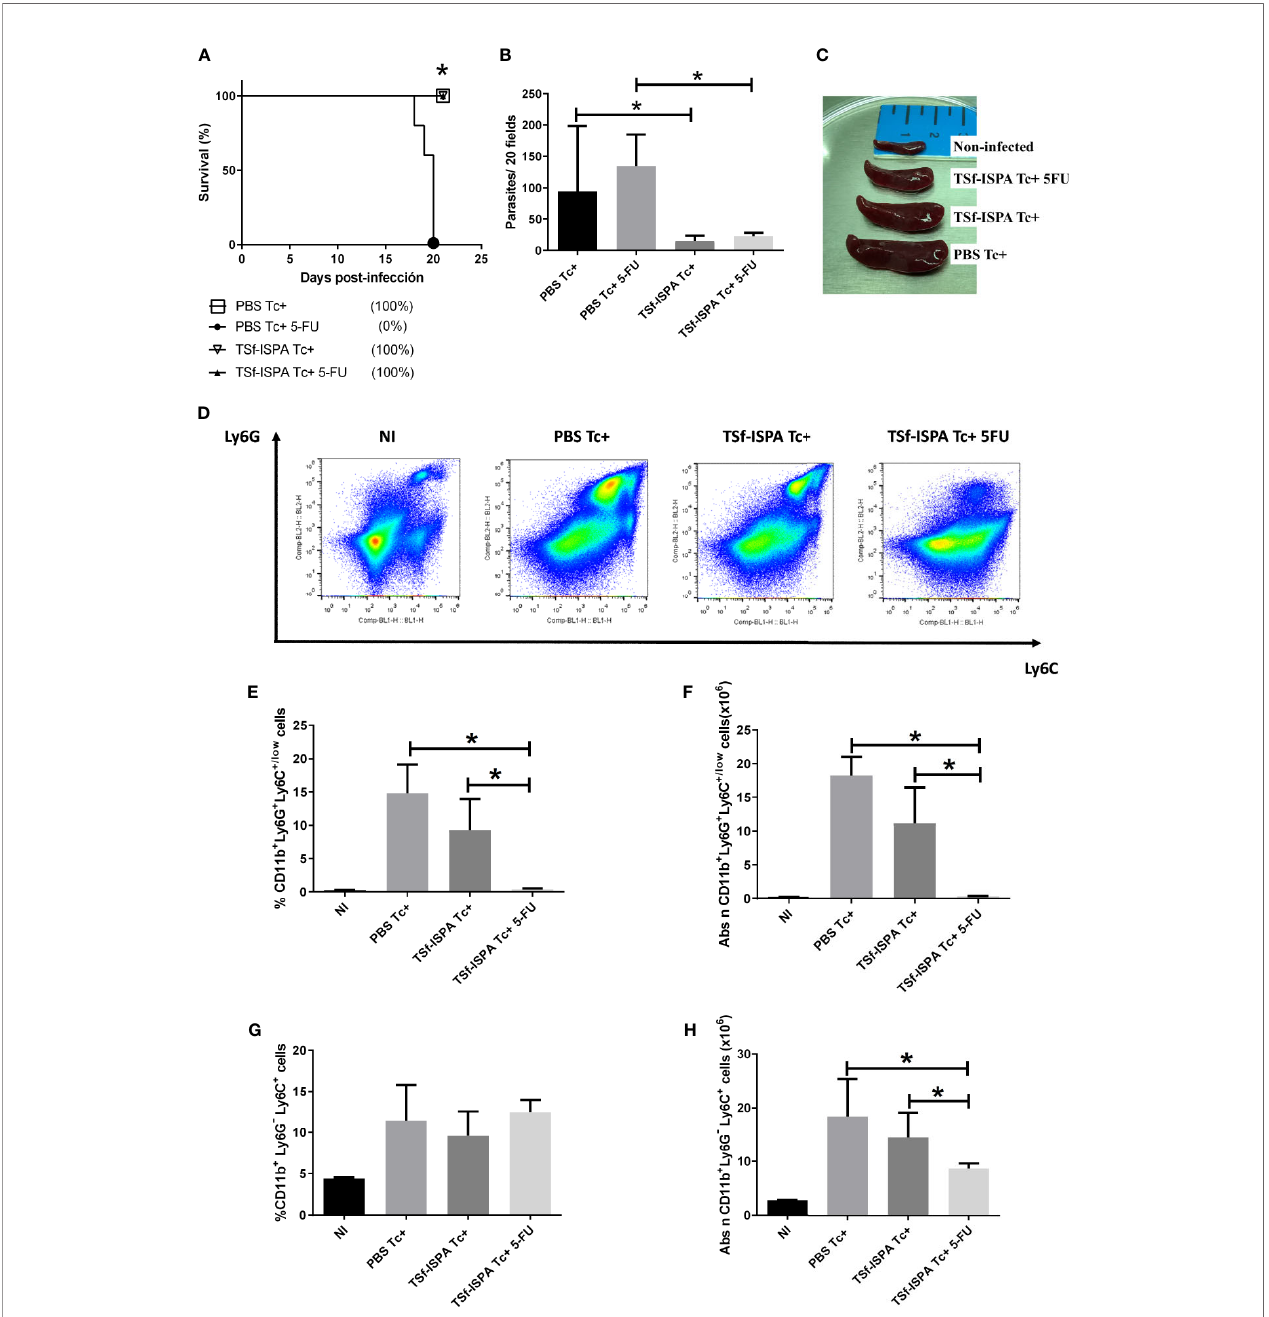
FIGURE 1 | 5FU treatment at day 15 p.i. strongly affects MDSCs and clinical parameters of T. cruzi infection. Mice immunized with TSf-ISPA or PBS were treated or not with 5FU and challenged with 900 trypomastigotes of the Tulahuen strain. (A) Survival rates are shown for TSf-ISPA immunized and infected mice (TSf-ISPA Tc+), PBS-inoculated and infected mice (PBS Tc+), TSf-ISPA immunized, infected and 5FU-treated mice (TSf-ISPA Tc+ 5FU) and PBS-inoculated, infected and 5FU-treated mice (PBS Tc+ 5FU). (B) Parasitemia from PBS Tc+ mice, PBS Tc+ 5FU mice, TSf-ISPA Tc+ mice and TSf-ISPA Tc+ 5FU at day 20 p.i. At 21 day p.i., mice were sacri fi ced to analyze the ef fi cacy of MDSC depletion and the expression of Ly6C, Ly6G and CD11b were assessed by fl ow cytometry (FACS) in control non-infected (NI), PBS Tc+, TSf-ISPA Tc+ and TSf-ISPA Tc+ 5FU. (C) Representative picture of the size of the spleens from experimental groups of mice at day 21 p.i. (Mice from the PBS Tc+ 5FU group died before day 21 p.i. when spleens were extracted). (D) Representative dot plots of the expression of Ly6G and Ly6C in mouse spleen from each experimental group. (E) Percentage of CD11b+ Ly6G+ Ly6C +/low cells. (F) Absolute number of CD11b+ Ly6G+ Ly6C +/low cells (x10 6 ), (G) Percentage of CD11b+ Ly6G- Ly6C+ cells. (H) Absolute number of CD11b+ Ly6G- Ly6C+ cells (x10 6 ). Data are expressed as means + standard deviations. The results are representative of two independent experiments (n=5 mice per group), *p < 0,05, Mantel – Cox Long rank test was used for survival analysis between all groups vs PBS Tc+ 5FU in Figure (A) *p < 0,05, Mann-Whitney test was used for comparison between indicated groups in graphics (B, E, F, H)